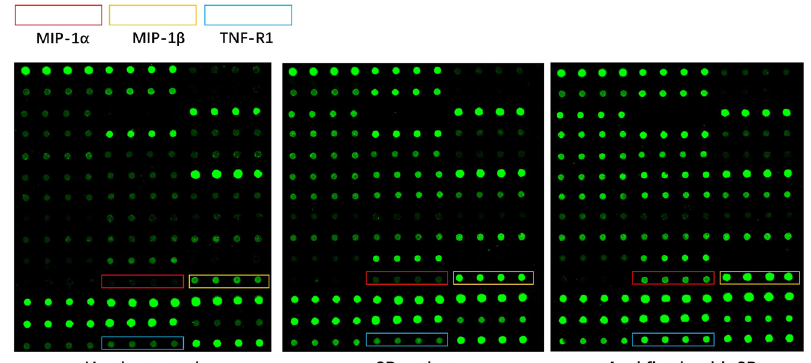
Figure1: Samplesdetectedbyantibodyarray assay. Example of laser scanned results from antibody array assay with samples of healthy control (left), chronic diarrhea patient, and anal fistula patient